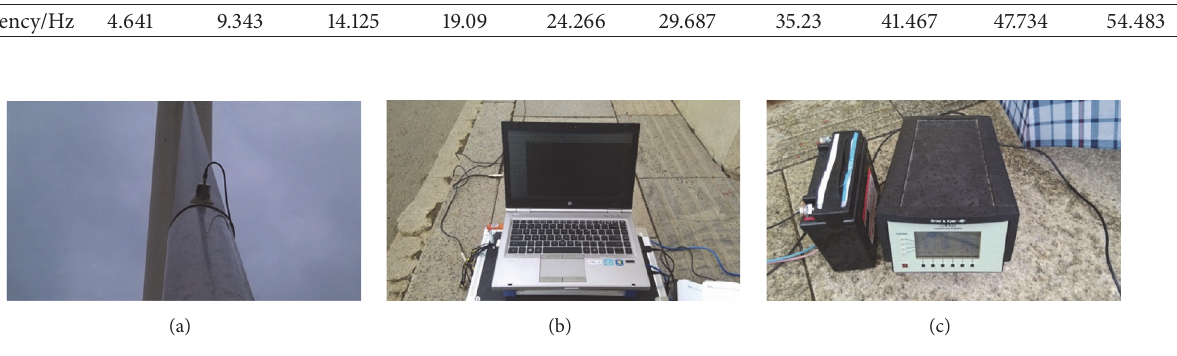
Figure 21: Test instruments.